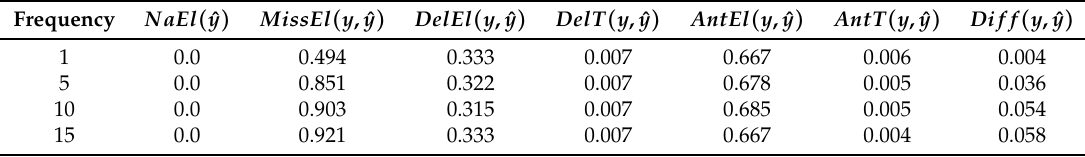
Table 8. Error values for the nearest joining method for different requested sampling